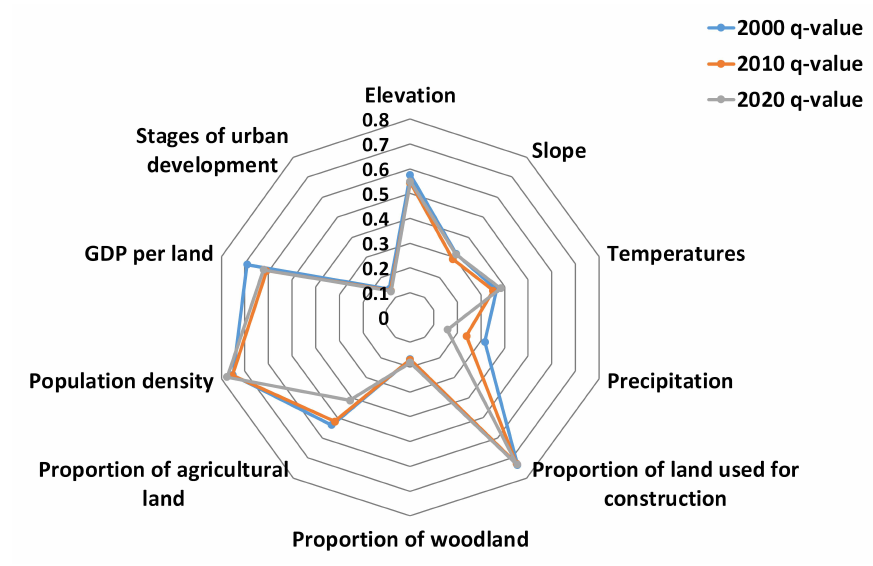
Figure 7. Geographical detector model factor analysis radar map. Table 4. Explanatory power of natural and socioeconomic factors influencing resource-based cities in the YRB from